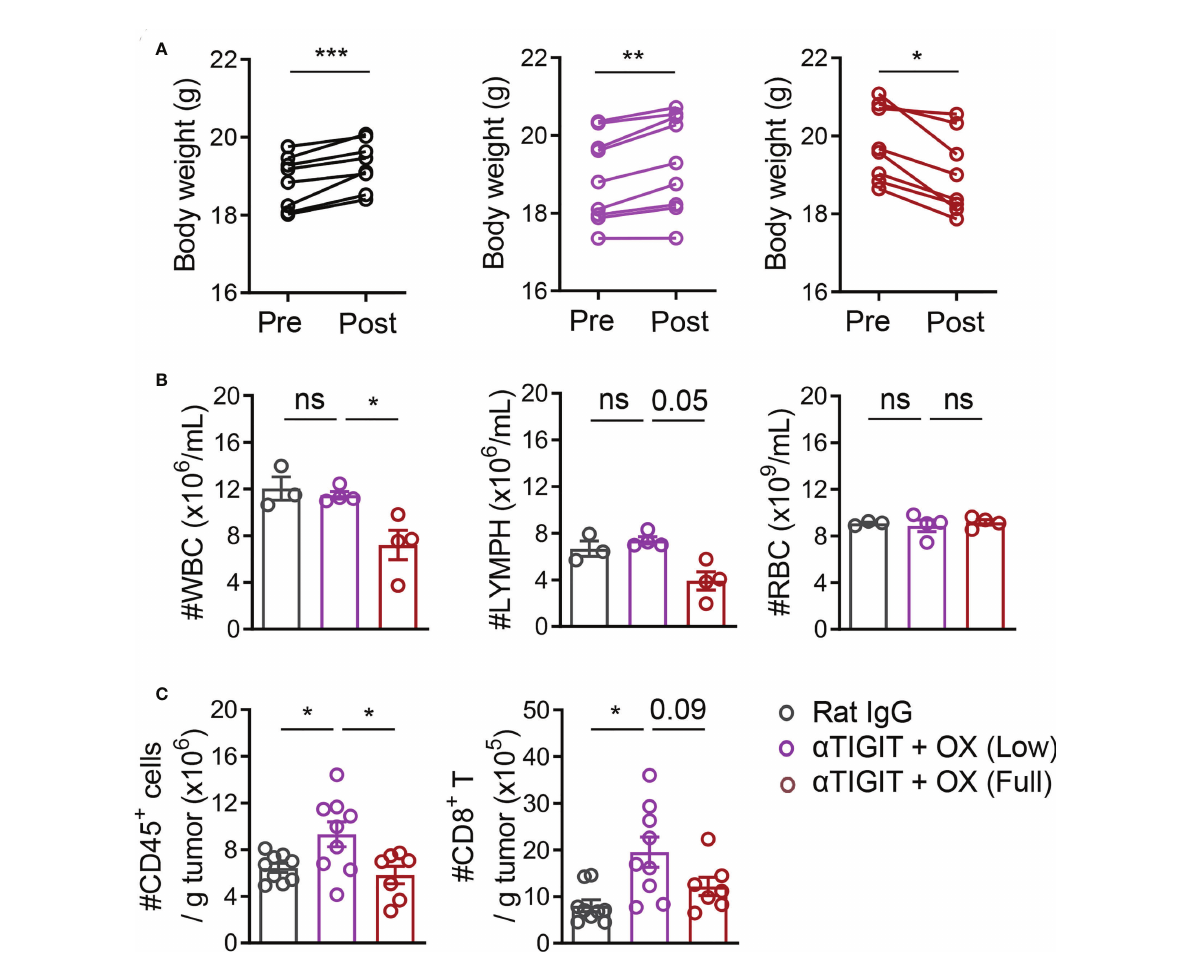
FIGURE 4 Full-dose oxaliplatin induces greater immunosuppression. (A) , Body weight in CT26-bearing mice before or after treatment with Rat IgG, anti-TIGIT mAbs plus various-dose OX for 2 days. (B) , The counts of WBC (left), Lymph (mid) and RBC (right) in peripheral blood of CT26- bearing mice. (C) , Absolute numbers of tumor-in fi ltrating CD45 + cells and CD8 + T cells. Each symbol represents an individual mouse. Data were representative of at least two independent experiments. Error bars represent means ± SEM. Statistical signi fi cance was determined using paired two-tailed t test (A) or one-way ANOVA followed by Tukey ’ s multiple-comparisons (B, C) . ns, p > 0.05; *p < 0.05; **p < 0.01 and ***p <